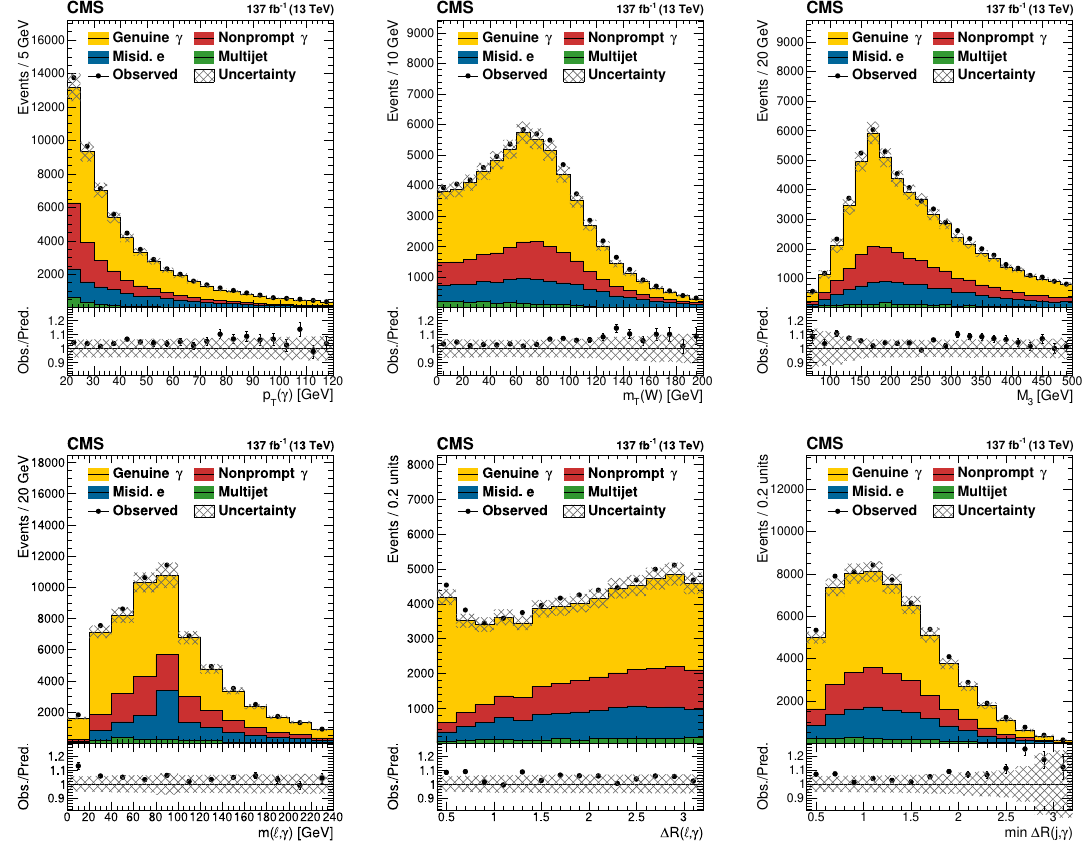
( γ ) , the transverse mass m (W) of the W boson candidate, the Figure 2 . Distribution of p T T three-jet invariant mass M (upper row); the invariant mass m ( ‘, γ ) of the lepton and the photon, 3 the angular separation ∆ R ( ‘, γ ) of the lepton and the photon, and the minimal angular separation min ∆ R ( j, γ ) of the photon and all jets (lower row) in the SR3p region. The backgrounds are normalized according to the methods described in section 7 and the pre-fit systematic uncertainties are shown as a hatched band. The lower panels show the ratio of the observed to the predicted event